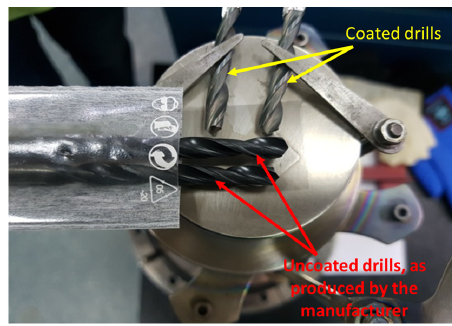
Figure 6. Photograph of carbon thin film covered drills (gray) and uncoated drills (black) presented for comparison, immediately after deposition/unpacking.